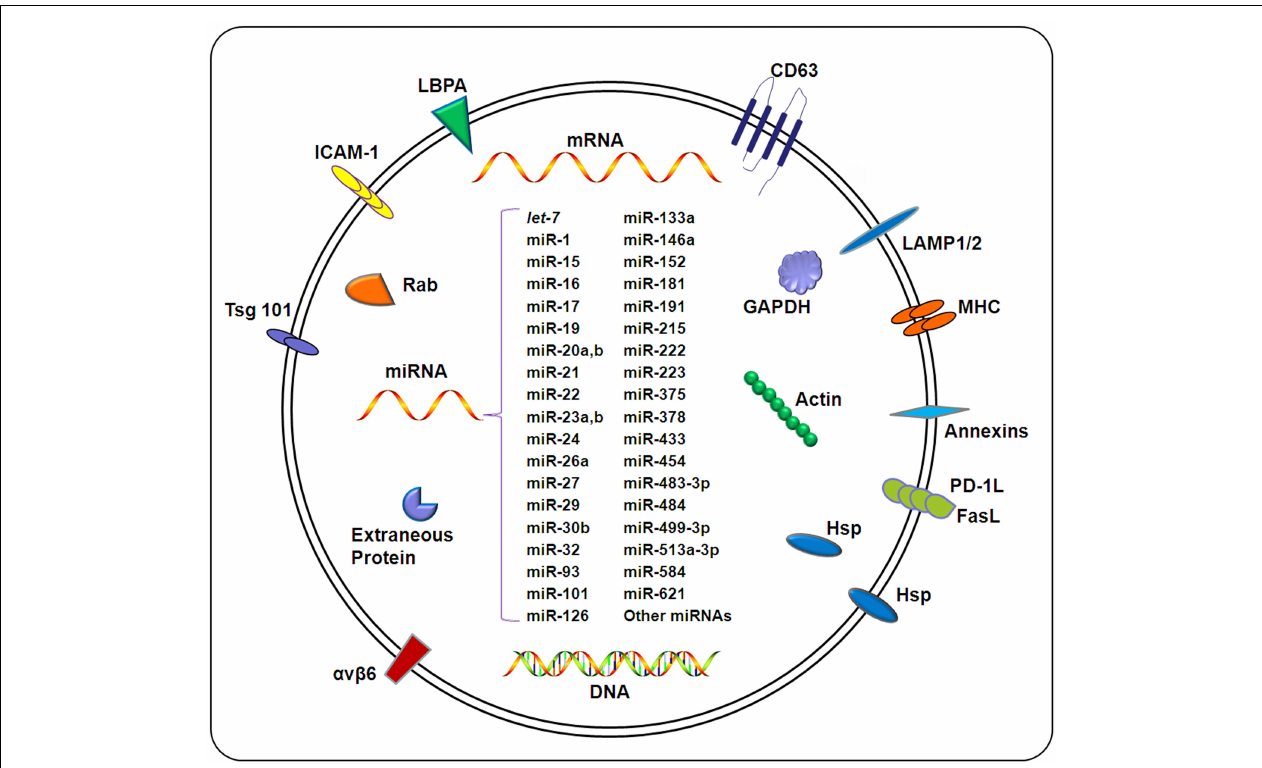
exosomes can be transferred from origin cells to target cells, resulting in an elaborate intercellular communication network. Exosomal miRNAs confirmed by different methods (e.g., microarray and qPCR) under different pathological conditions are listed in this figure. For details, also see Table 1 .